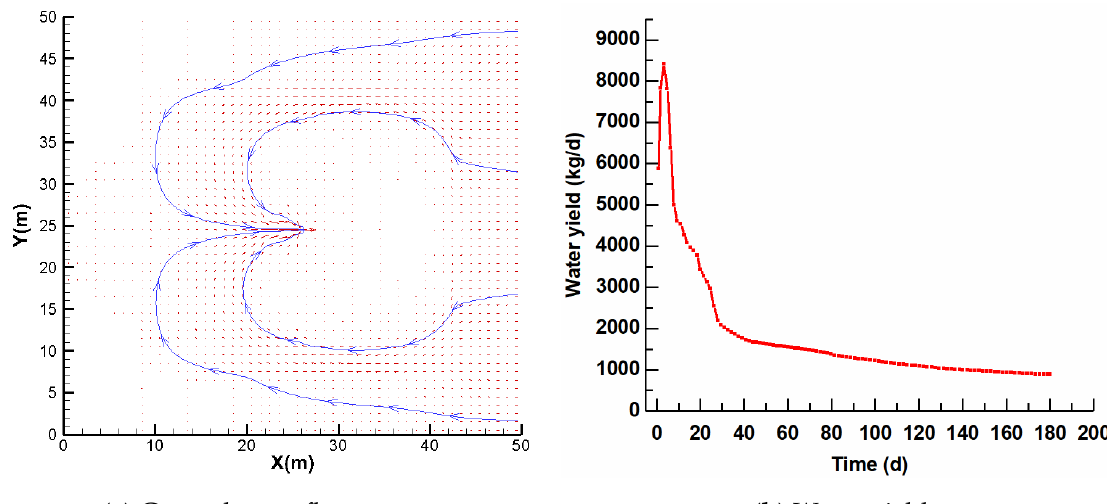
Figure 2. Groundwater flow traces and water yield of production well.